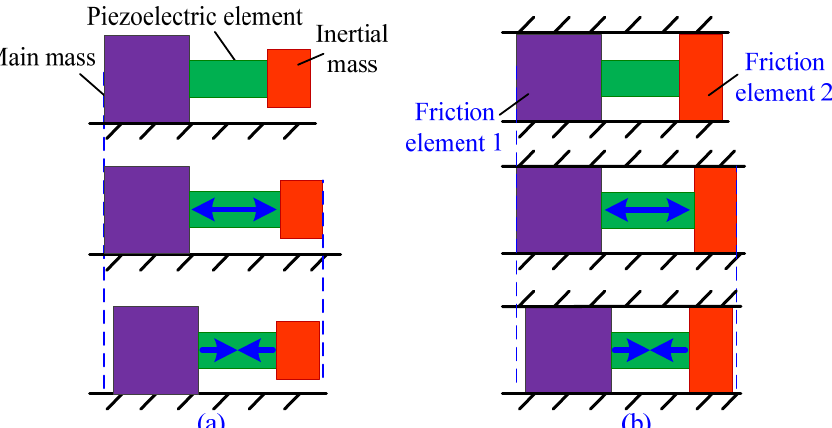
Figure 1. The working principles of ( a ) the traditional inertial impact actuator and ( b ) the asymmetric friction inertial impact actuator.